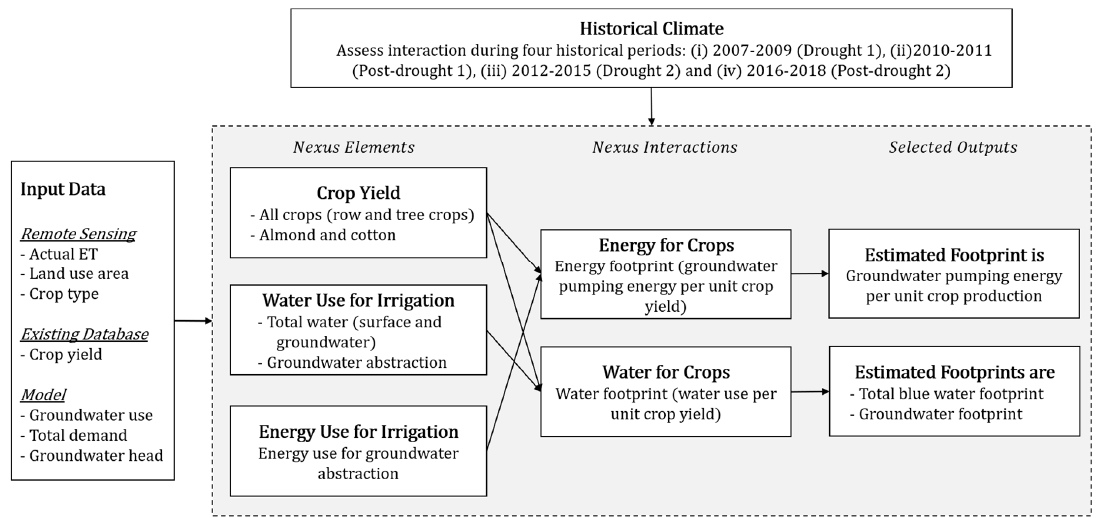
Figure 2. The research framework that represents the connectivity of CEW nexus components and the workflow for analyses.